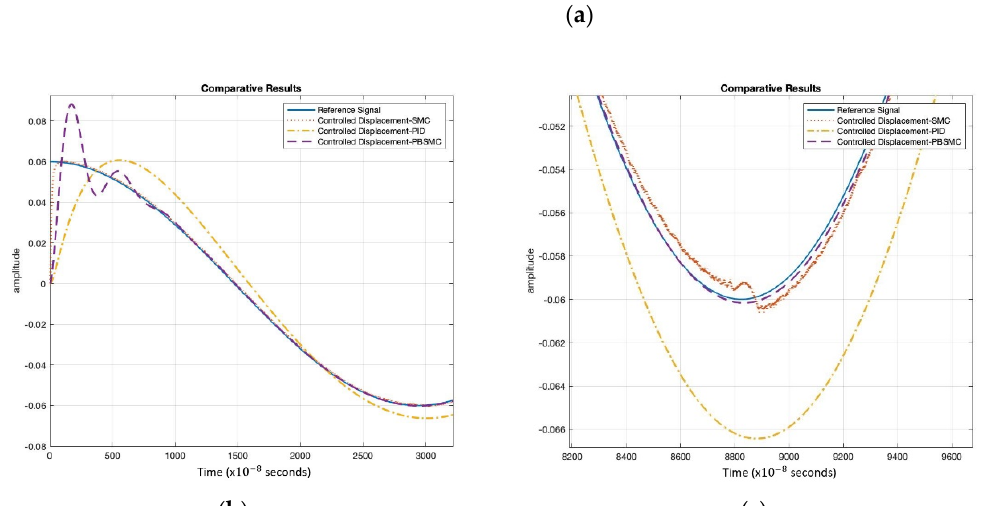
Figure 7. ( a ) PBSMC, SMC, and PID Controller Tracking Performance Comparison, ( b ) Initial Oscillations, ( c ) Steady-State Tracking Performance.